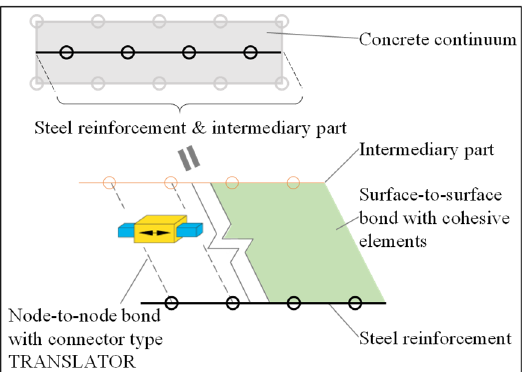
Figure 8. Illustration of the bond between the steel reinforcement and the concrete built using the connector method or cohesive method.